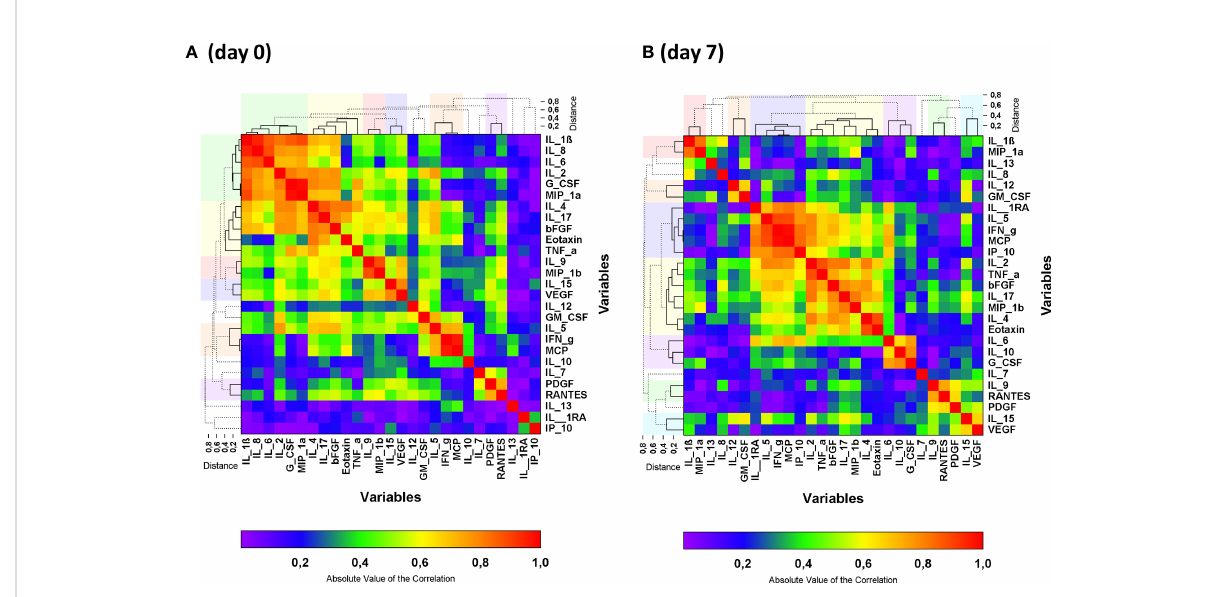
FIGURE 2 Heat map of the absolute values of the correlation matrix at baseline (day 0) (A) and on day 7 (B) of all patients. Clustered cytokines are indicated by the solid lines in the dendrograms and the clusters are indicated by the colors above and beside the graph. Non-clustered cytokines are shown by the dashed lines in the dendrogram. Clusters were formed by the unweighted group method. Cluster reports for the absolute values of the correlation matrix are presented in Table 2A.